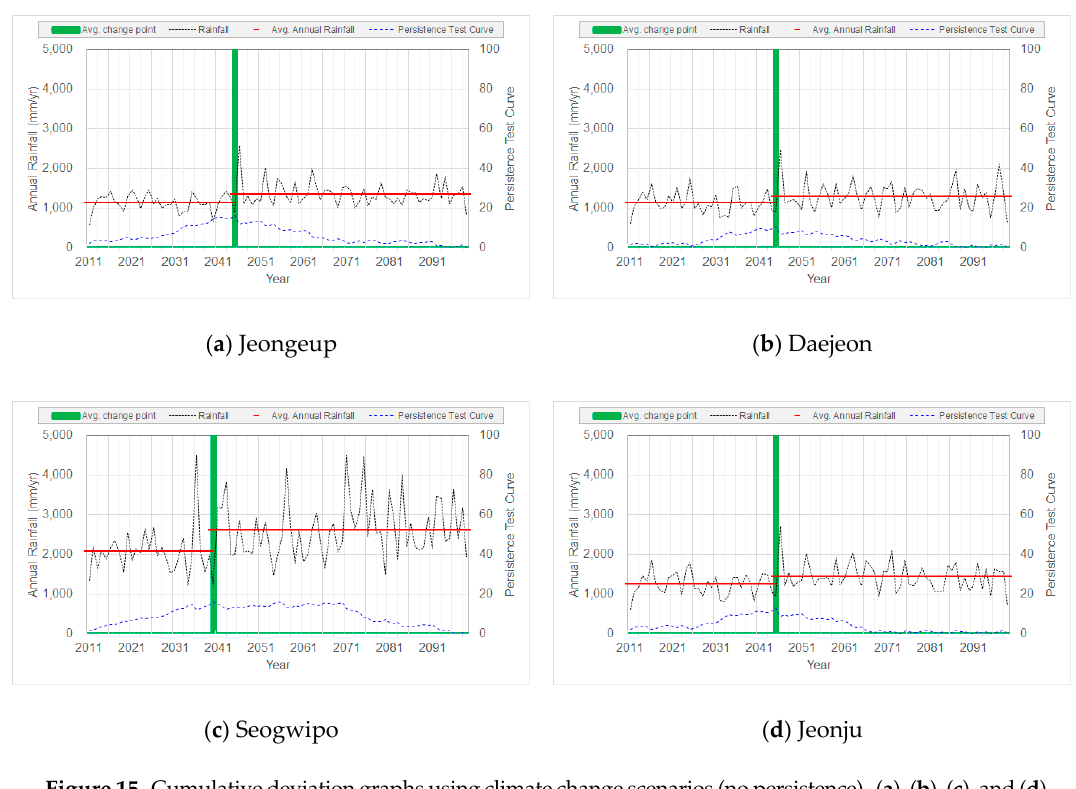
Figure 15. Cumulative deviation graphs using climate change scenarios (no persistence). ( a ), ( b ), ( c ), and ( d ) each represent graphs of Jeongeup, Daejeon, Seogwipo, and Jeonju.